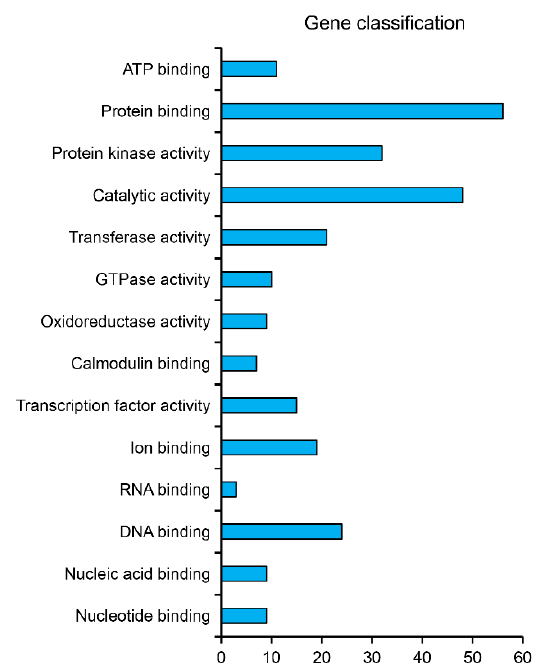
Figure 3. Functional classification of the targets of the miR319a and miR6300 . The gene classification analysis was on the basis of GO enrichment. The ordinate represents the gene functions, and abscissa represents the number of genes.